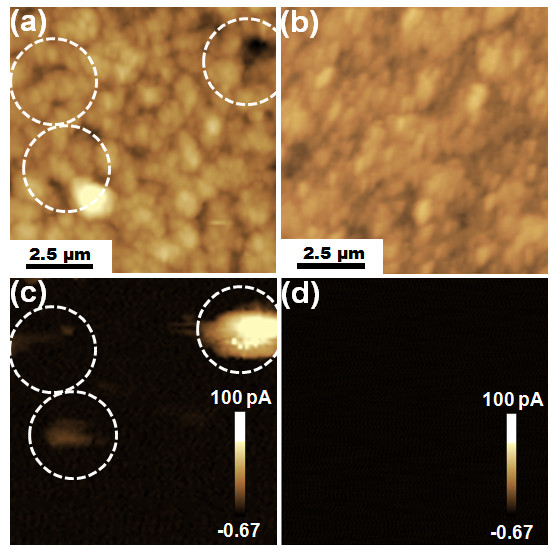
AFM topographies of 0.2-μm-thick BaTiO3thin films on (a) Cu and (b) SUS substrates. Current images of the films on (c) Cu and (d) SUS substrates.